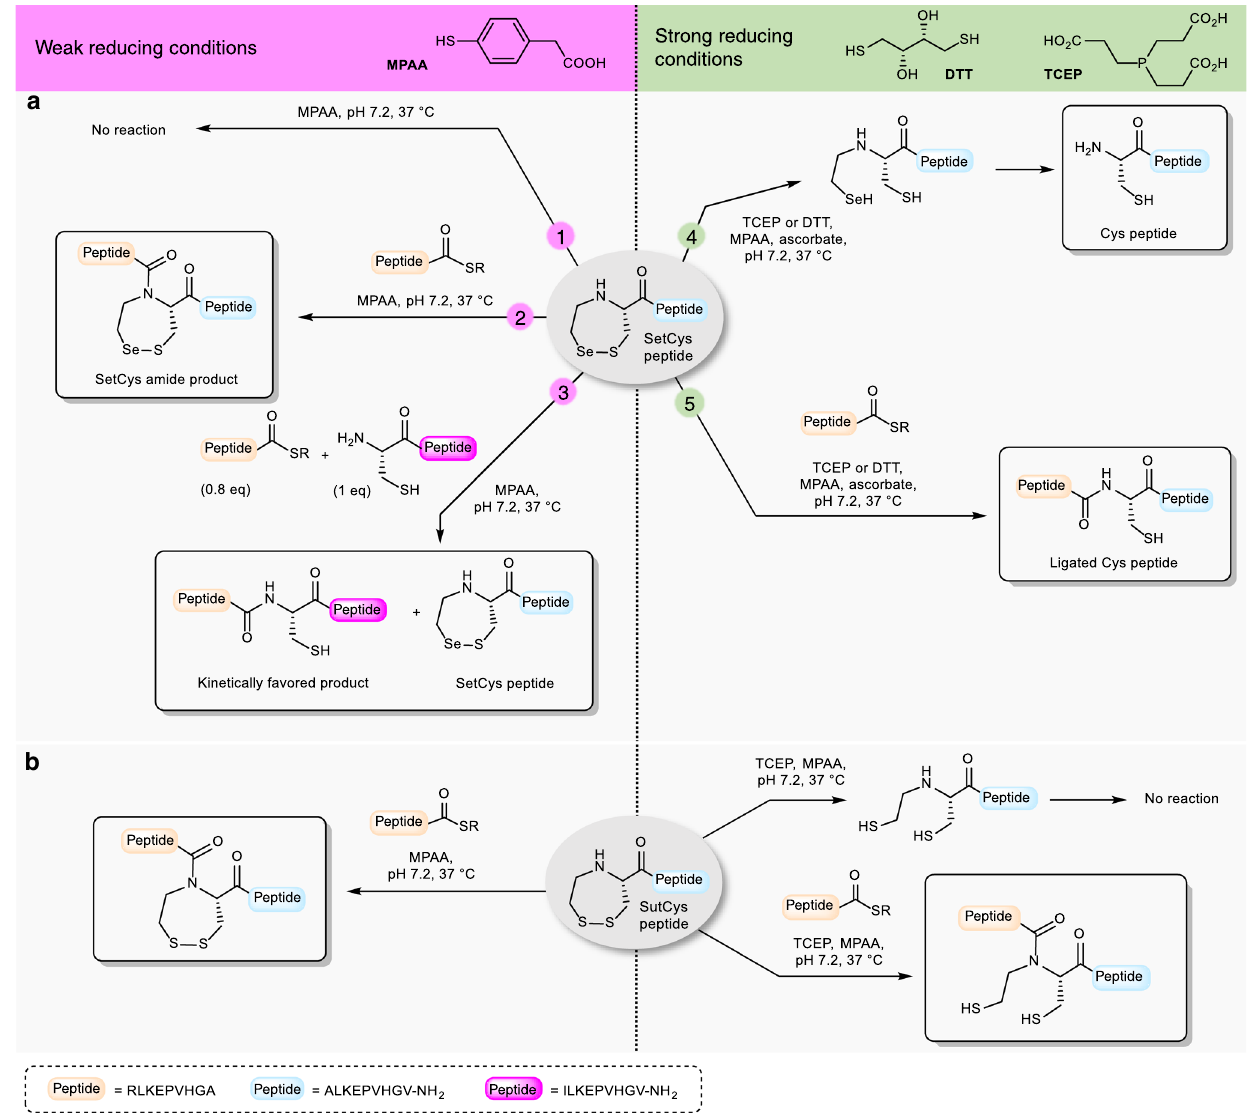
Fig. 2 Reactivity of N -(2-chalcogenoethyl)cysteine (SetCys and SutCys) peptides as a function of the reducing strength of the mixture. a The reactivity of N -(2-selenoethyl)cysteine (SetCys) peptides is controlled by the reducing strength of the mixture. The numbers on the arrows indicate different experimental conditions. Conditions 1 – 3 ( − SR = 3-mercaptopropionic acid, MPA): weakly reducing conditions, typically in the presence of an excess of 4-mercaptophenylacetic acid (MPAA) at neutral pH. Conditions 4 and 5 ( − SR = MPA or MPAA): strong reducing conditions, typically in the presence of dithiothreitol (DTT) or tris (2-carboxyethyl)phosphine (TCEP) at neutral pH. b Ligation of an N -(2-sulfanylethyl)cysteine (SutCys) peptide with a peptide alkyl thioester under weak or strong reducing